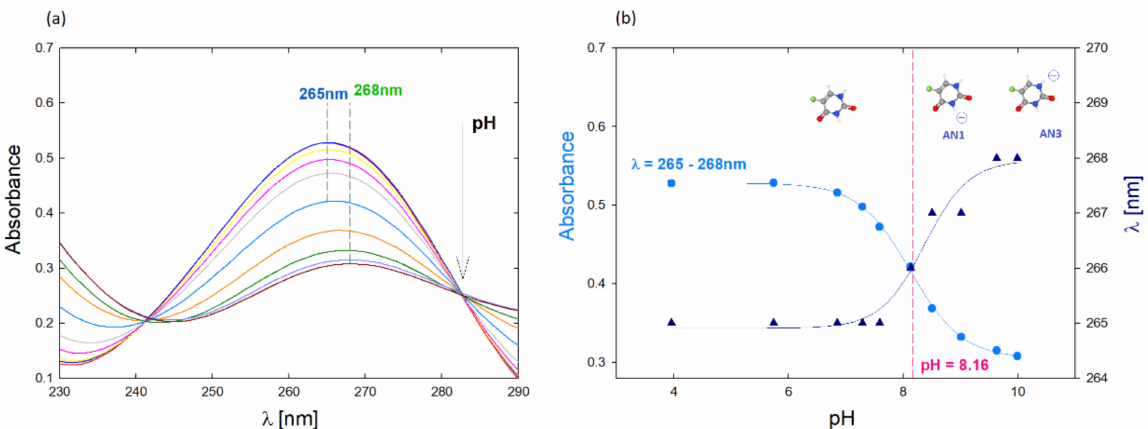
Figure 1. ( a ) UV-Vis spectrum of the aqueous 5-FU solution depending on the pH, c = 7.7 µ M; ( b ) Effect of pH on the position of the maximum absorbance of the spectrum and the dependence of absorbance for λ = 265 nm on the pH of the